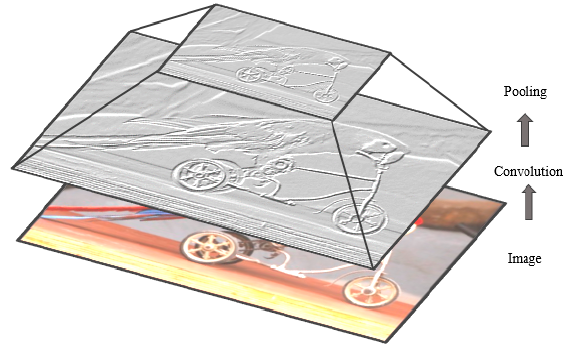
Figure 10. Feature maps after performing convolution and pooling operations.